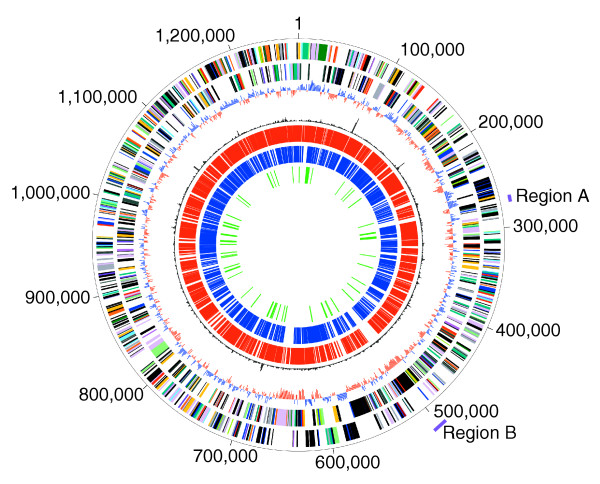
Circular map comparing the wMel genome with the wAna, wSim and wMoj assemblies. Ring 1 (outermost ring): forward strand genes; ring 2: reverse strand genes; ring 3: GC-skew plot; ring 4: X2 analysis of trinucleotide composition, with peaks indicating atypical regions; ring 5: wMel genes present in wAna assembly; ring 6: wMel genes present in the wSim assembly; ring 7: wMel genes present in wMoj assembly. Large regions on the wMel genome that were not recovered in the wAna or wSim assemblies are marked on the outside (regions A, B).